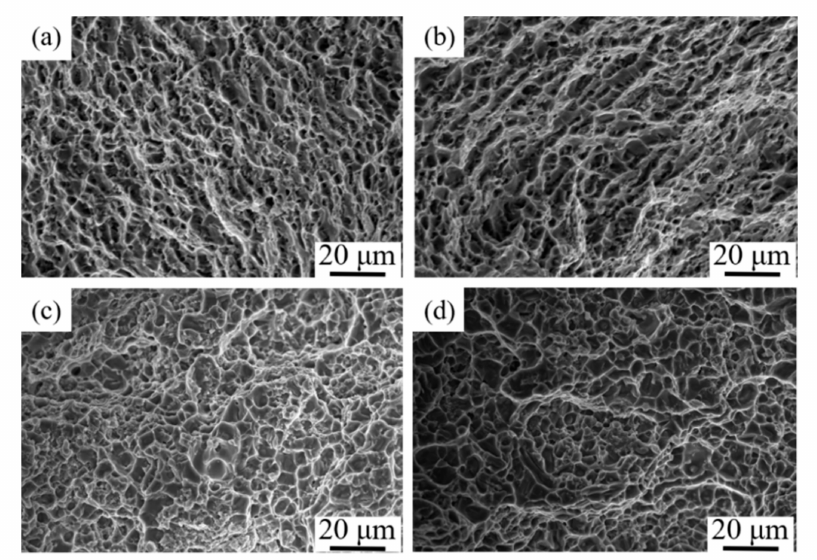
Figure 9. Fracture morphology of tensile-tested specimens: ( a ) X direction in the as-deposited samples; ( b ) Z direction in the as-deposited samples; ( c ) X direction in the T6 heat-treated samples; ( d ) Z direction in the T6 heat-treated